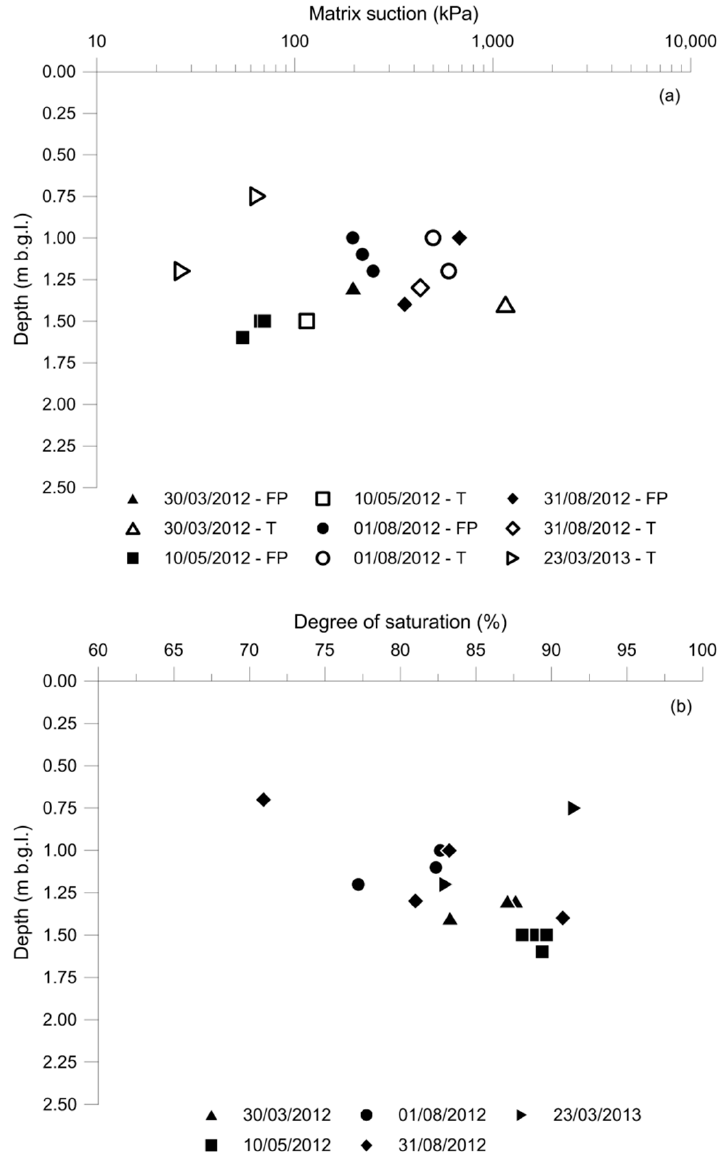
Figure 5. Water retention data of the Paola Doce fissured clay sampled at different depths and during different periods of the year: ( a ) matrix suction, measured with the filter paper technique, FP, and high-capacity tensiometers, T; ( b ) degree of saturation.